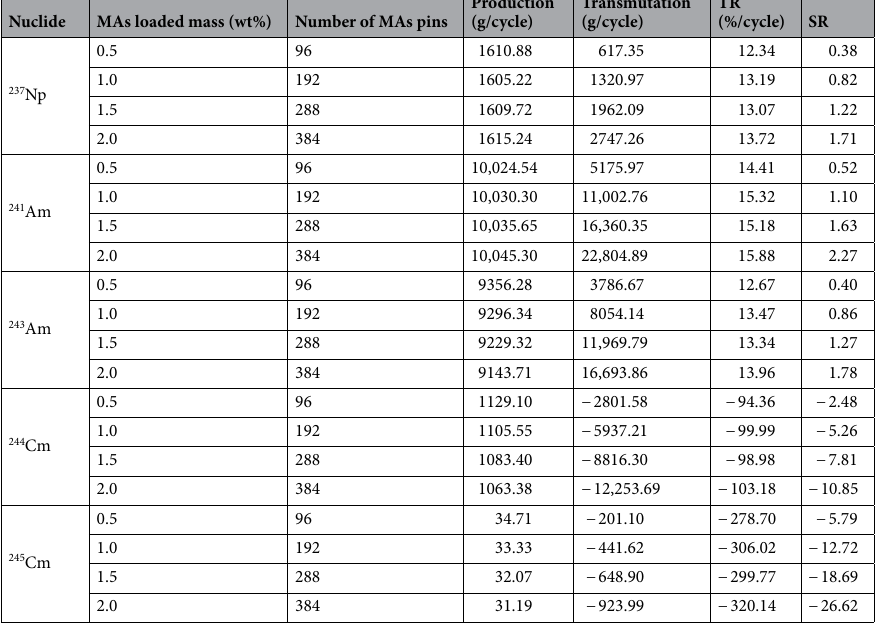
Table 5. The transmutation rate and support of MAs considering different loading amounts.